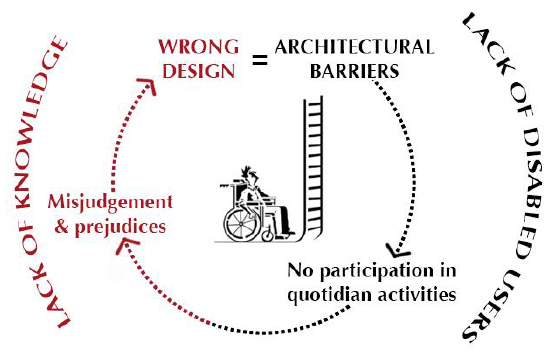
Figure 1. Marta Bordas Eddy’s endless loop [28] (p. 25).